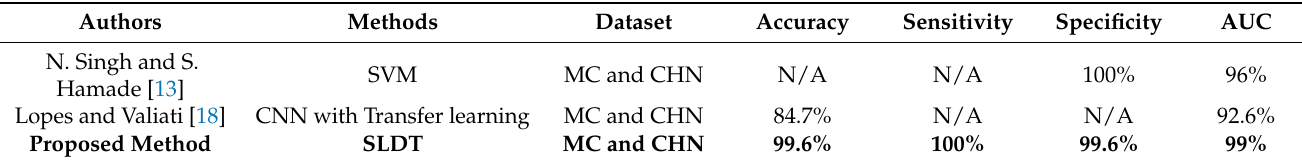
Table 3. Performance measures of the proposed method with existing methods by the combined dataset 1 (MC and CHN).